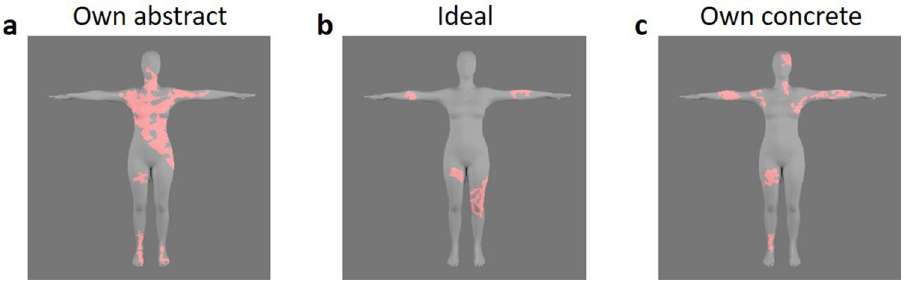
Figure 4. Diagnostic areas. Areas that significantly correlated with participants’ responses are indicated in red for all three conditions: (a) own abstract ( Which of these two bodies looks most like your own? ), (b) ideal ( Which of these two bodies looks most like the body you would like to have? ), and (c) own concrete ( Which of these two bodies looks most like the body you would use for online shopping? ). These areas identify clusters containing pixels for which luminance variation significantly predicted the different representations.